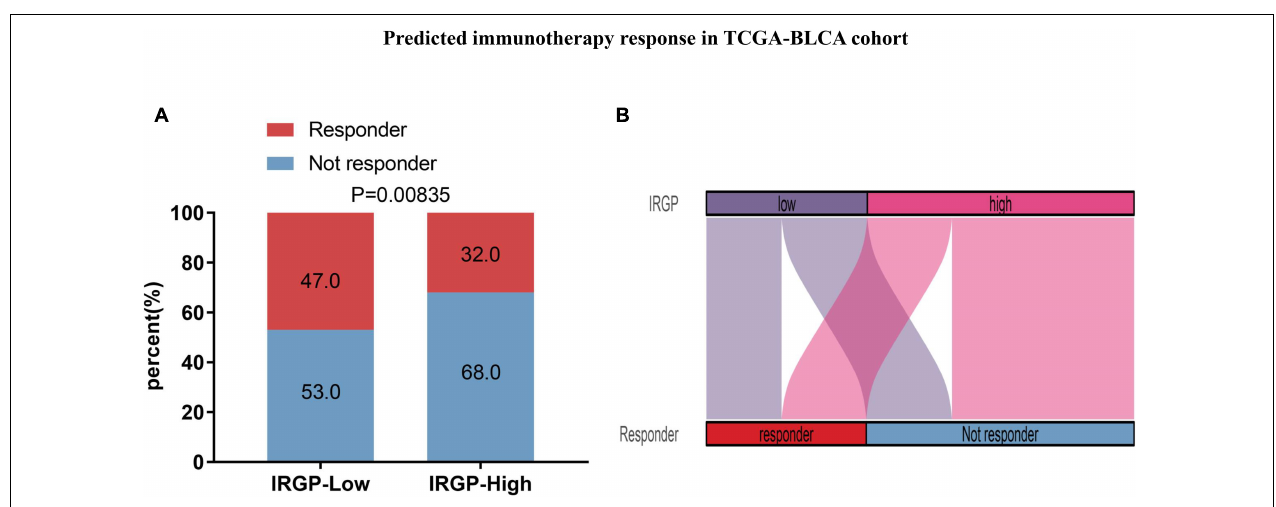
FIGURE 7 | GSEA of the IRGP-signature in BLCA patients. (A) The significantly enriched GO terms in TCGA cohort. (B) The significantly enriched KEGG pathways in TCGA cohort. Circle plot of gene in GO (C) and KEGG (D) pathways. GSEA, Gene Set Enrichment Analysis; IRGP, immune-related gene pair; BLCA, bladder cancer; GO, Gene Ontology; KEGG, Kyoto Encyclopedia of Genes and Genomes.